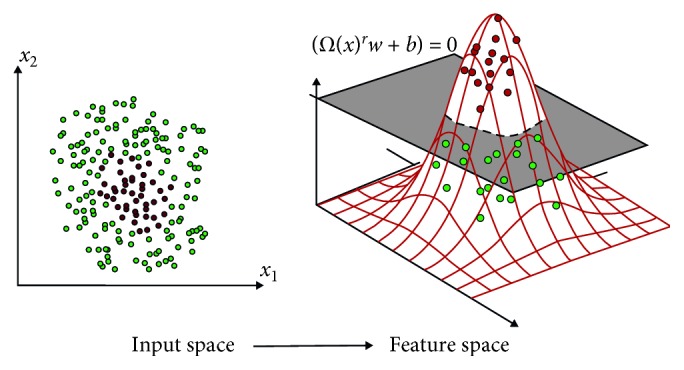
Example of nonlinear SVM [29].